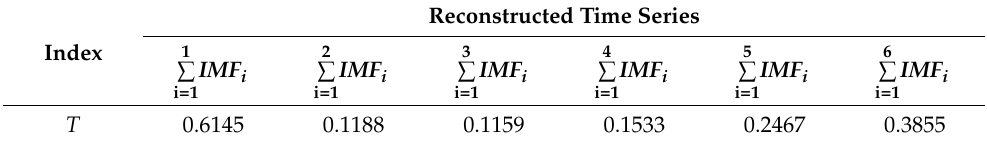
Table 2. Index T value of the different IMFs of T station retrieval.